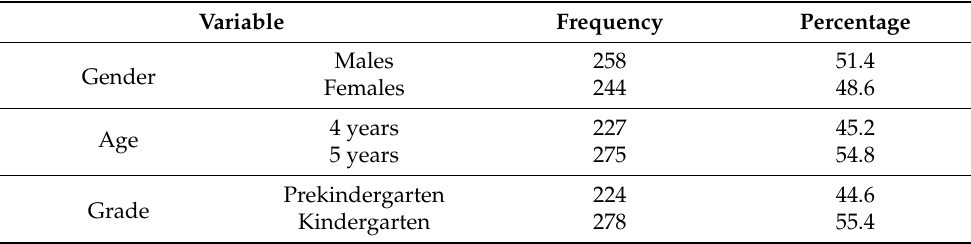
Table 1. Demographic variables of participating children: sex, age, and grade. Variable